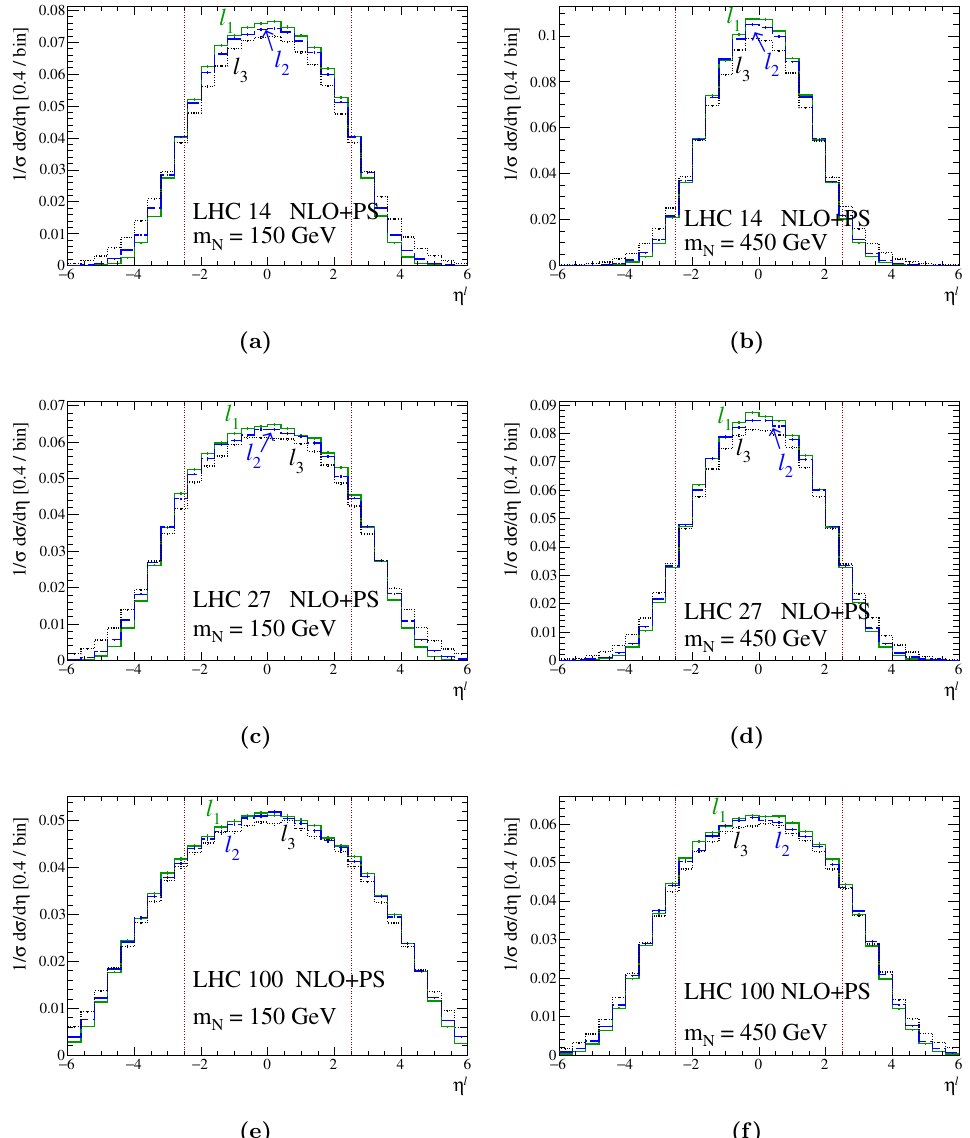
Figure 10. Same as (cid:12)gure 7 but at NLO+PS accuracy with particle-level reconstruction.